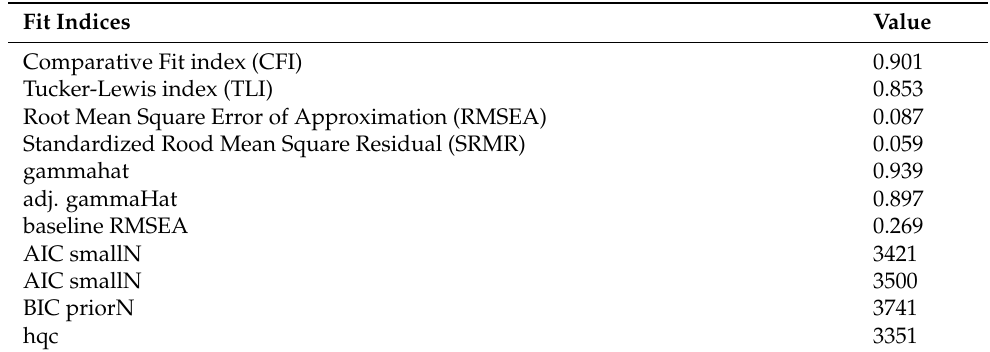
Table 9. Fit indices and variable coefficients of one latent variable confirmatory factor analysis model.